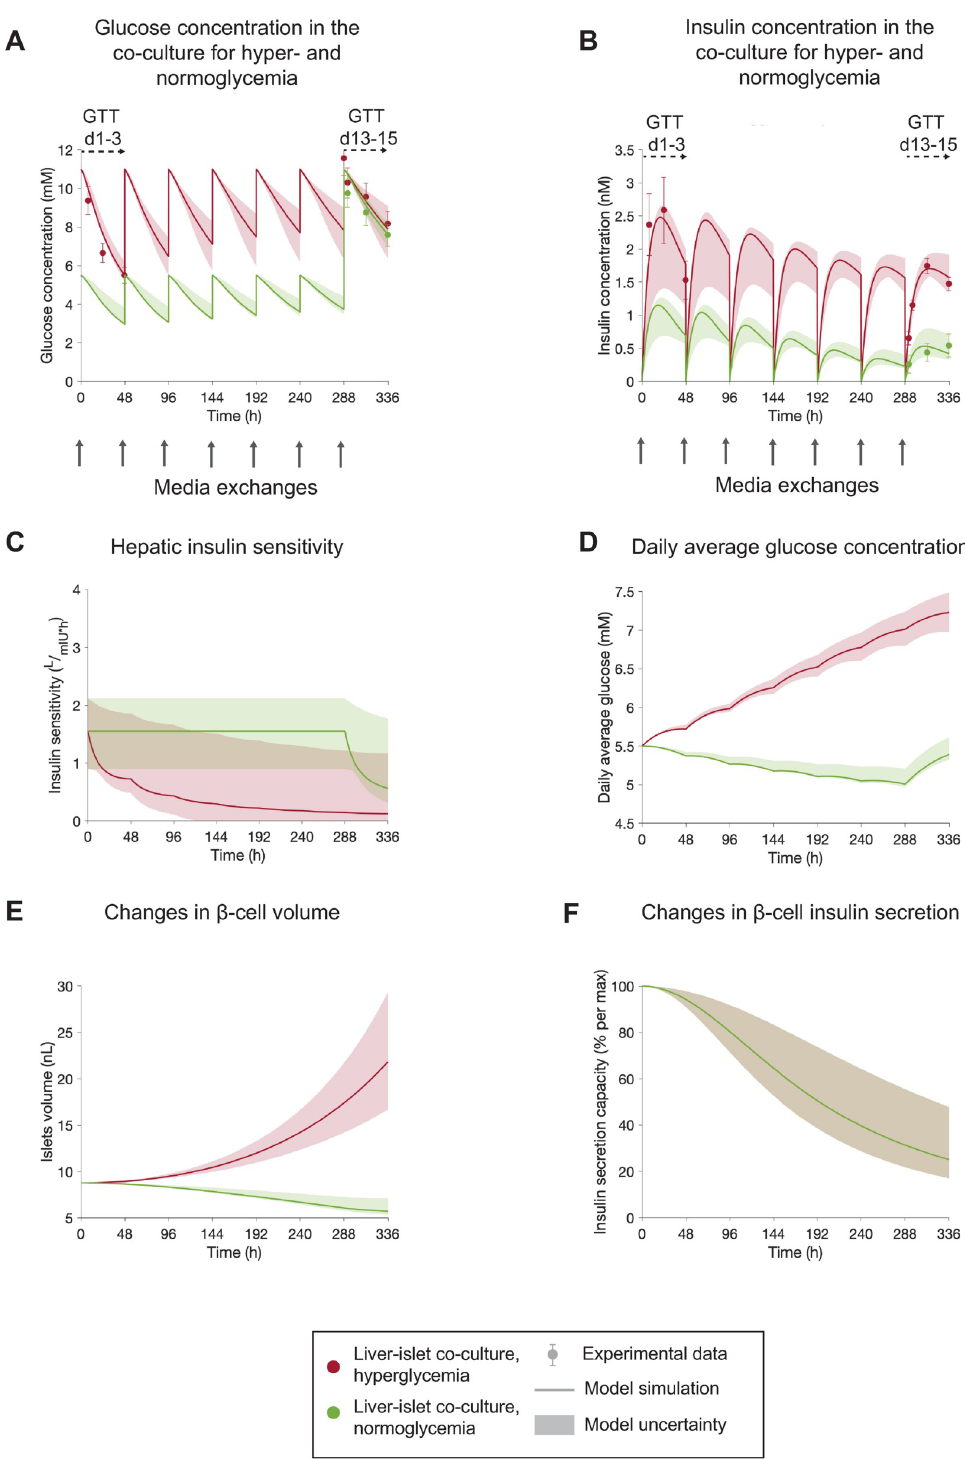
Fig 5. The computational model can explain impaired glucose homeostasis and β -cell dysfunction under varying glycemic conditions in HepaRG liver-islet MPS. The results correspond to a single experiment (experiment 3). A-B: Comparison between experimental measurements (markers) and model simulations (lines) of glucose concentration (A) , and insulin concentration (B) over the 15 days of liver-islet co-culture. Co-cultures were exposed to either a hyperglycemic (11 mM glucose, red) or normoglycemic medium (5.5 mM glucose, green) in each media exchange